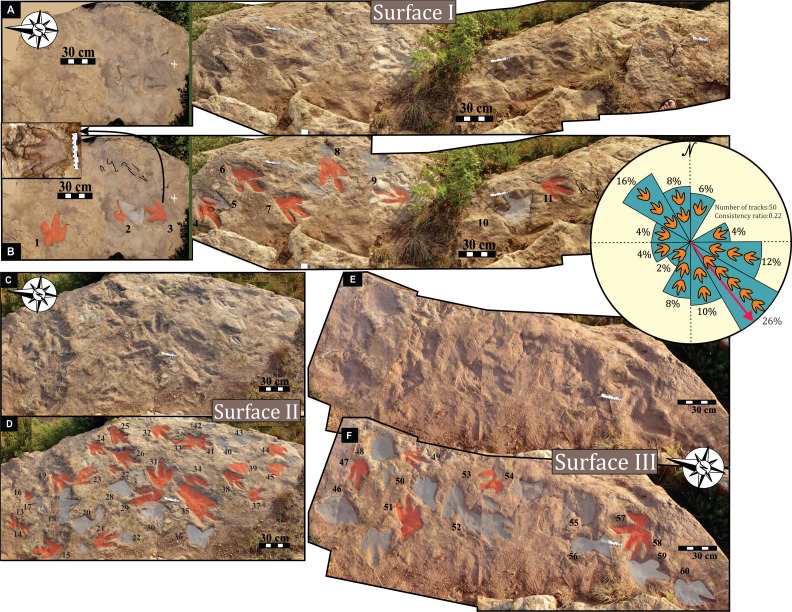
Field views of the Mafube dinosaur track site.Photographs (A, C, E) and their respective interpretative drawings (B, D, F) of Surfaces I, II, and III on the lowermost track palaeosurface with Surface I being the northern-most and Surface III being the southern-most surfaces, respectively. Tracks with reasonably well-defined outlines are shaded in red, and depressions that might represent additional tracks are shaded in grey, and black outlines show incomplete tracks. Inset shows the rose diagram generated from the orientation measurements of 50 tracks, and indicate a mean walking direction to ∼SE (143°), with and angular deviation of ±72°, a vector magnitude of ∼11 and consistency ratio of 0.22.